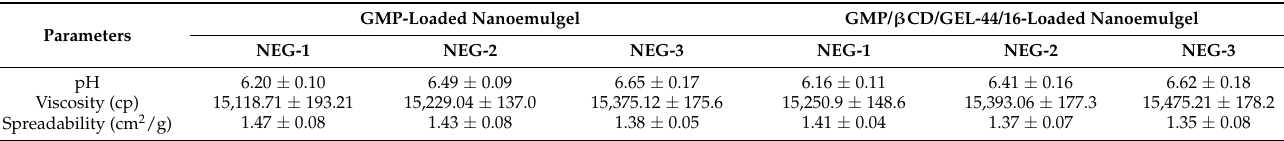
Table 6. Results of pH, viscosity, spreadability, and drug content of glimepiride-loaded (GMP) and inclusion complex-loaded (IC) nanoemulgels (Mean ± SD, n = 3).